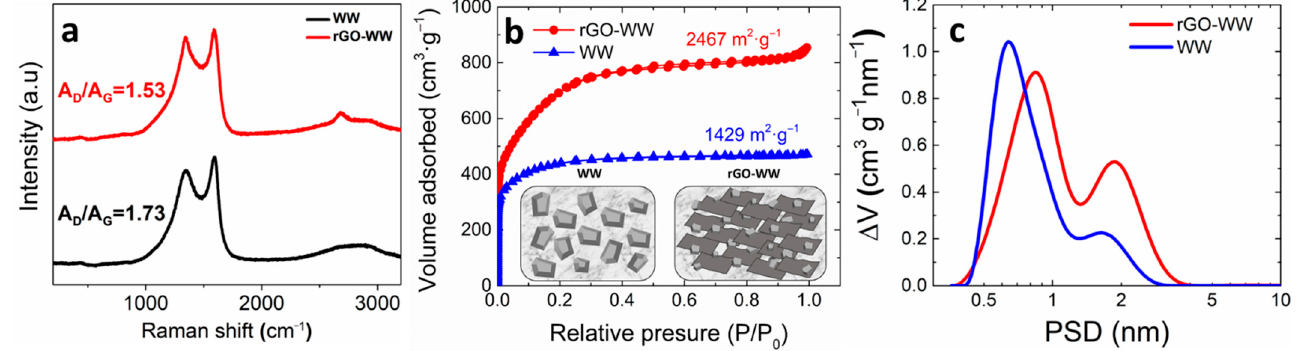
Figure 2. Raman spectra ( a ), nitrogen adsorption/desorption isotherms ( b ) and pore size distributions ( c ) measured for indicated samples.